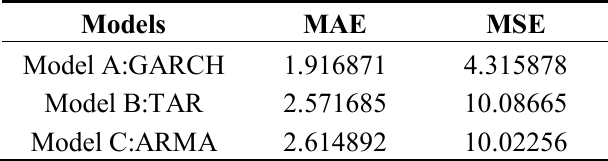
Table 2. Comparison of forecasting